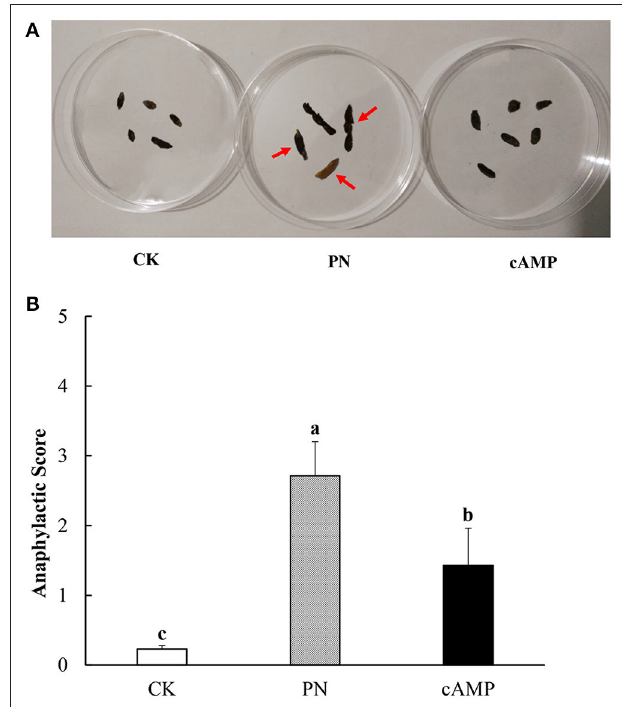
FIGURE 3 | Effect of oral administration with cAMP on clinical symptoms in PN-sensitized mice. (A) Morphological images of fecal samples. Fecal samples were collected within an hour of the last challenge. There were the CK group, the PN group, and the cAMP group from left to right. The red arrow indicates typical lesions. (B) Anaphylactic score. Data are expressed as the means ± SDs. Different lowercase letters represent mean significant difference ( p < 0.05) between the groups of